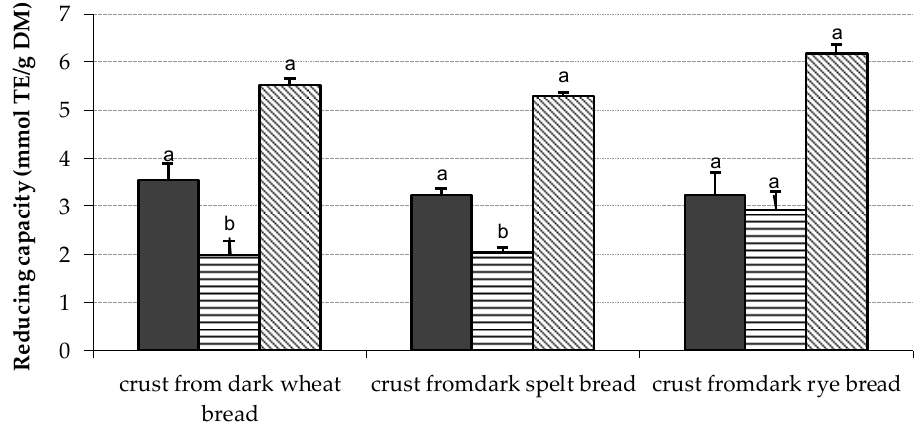
Figure 5. The total reducing capacity of crusts separated from dark breads baked at 240 ◦ C for 30 min. Data are the mean of three independent replicates ± SD. Similar letter as superscripts for bars related to the reducing capacity of hydrophilic or lipophilic or TRC indicates no significant differences ( p ≤ 0.05).